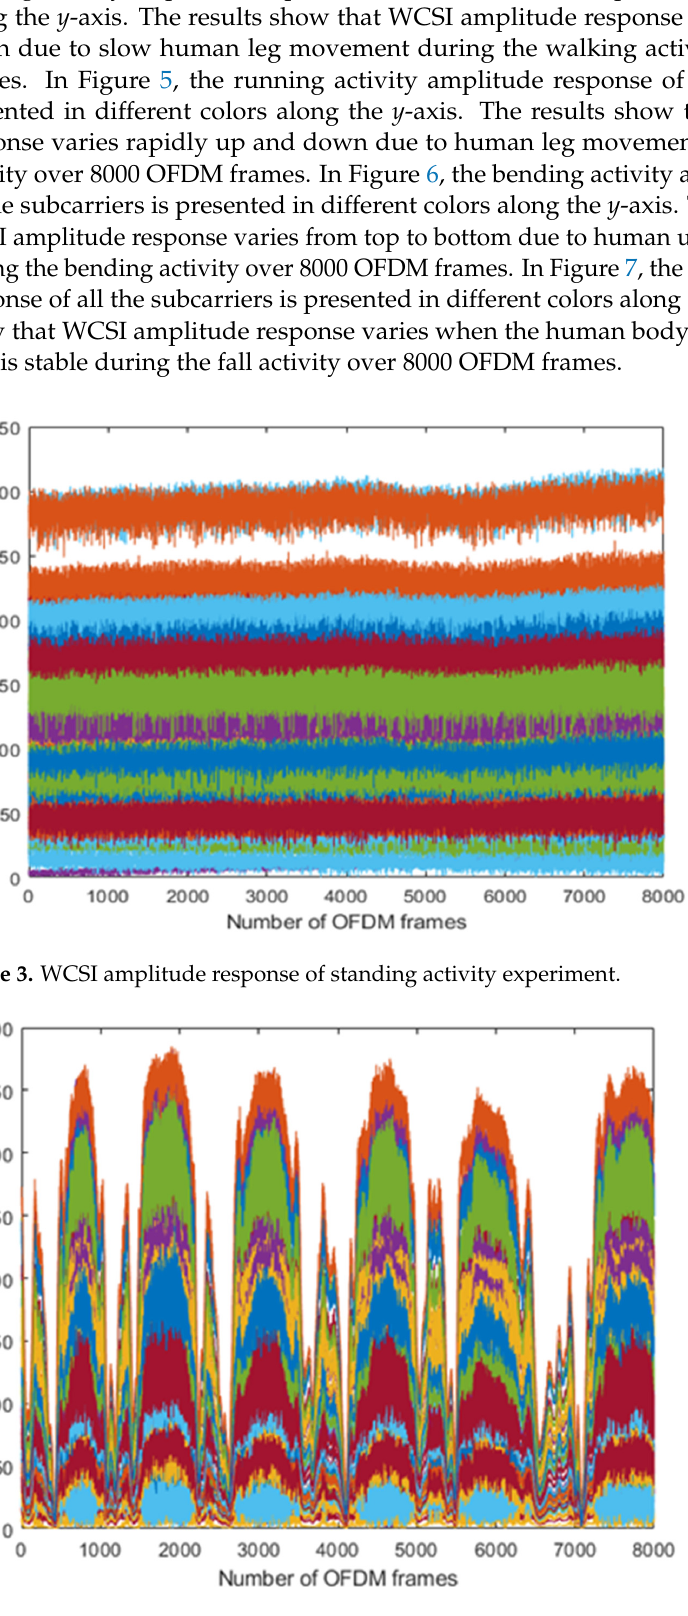
Figure 5. WCSI amplitude response of running activity experiment.